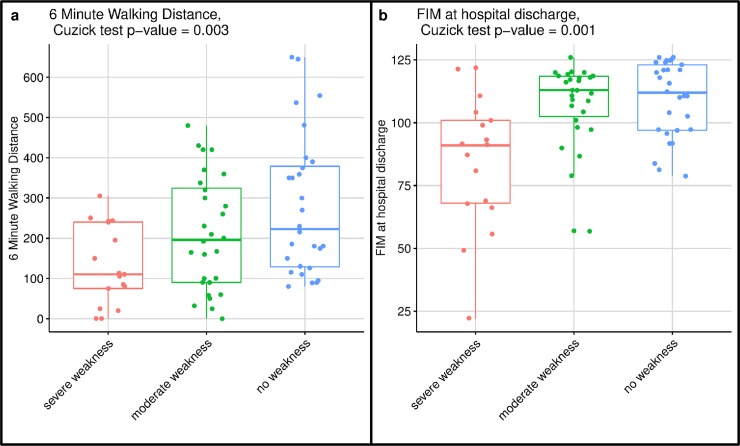
Illustration of the two primary outcomes per MRC-SS group.Illustration of the 6MWT (a) and the FIM (b) at hospital discharge with non-parametric Cuzick test clearly rejecting the null hypothesis in favour of alternative: values for severe weakness < no weakness and for severe weakness ≤ moderate weakness vales ≤ no weakness.